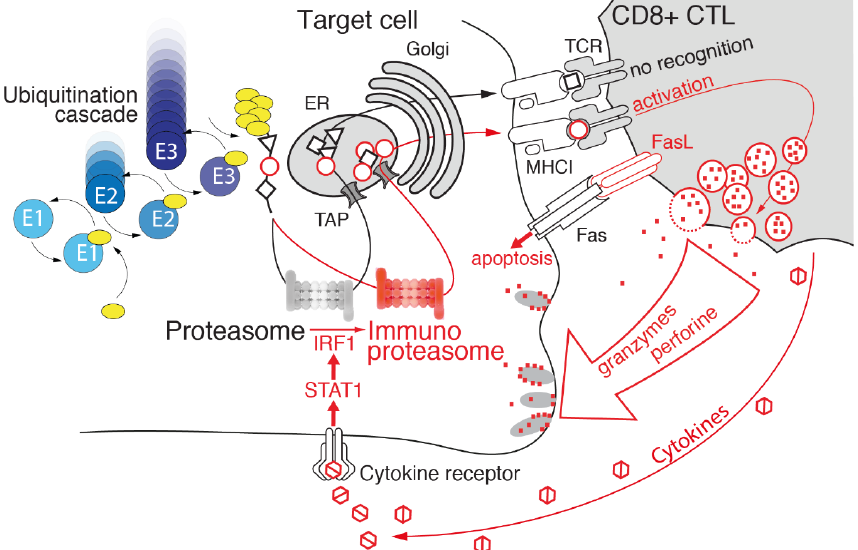
Figure 2. Immunoproteasome mediates cell cytotoxicity. The development of an inflammatory reaction, particularly the production of IFN γ and other inflammatory cytokines, induces the expression of the proteasome immune subunits in target cells and leads to efficient production of peptides beneficial in terms of presentation on the MHC class I and recognizable by CD8+ CTLs. Further elevation of the immunoproteasome (in red) mediated by increased production of inflammatory cytokines and subsequent generation of immunodominant peptides may function as a positive feedback loop, enhancing T cell-mediated cytotoxicity.